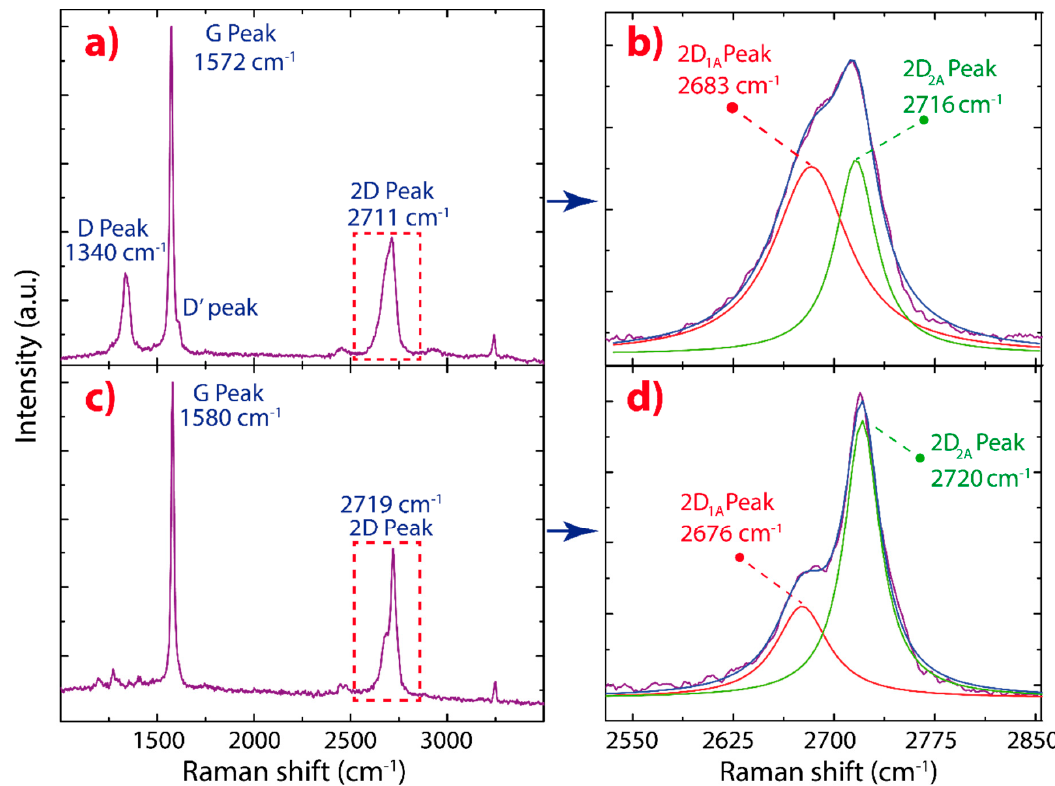
Figure 3. Raman spectra of ( a ) dispersed graphene after hydrothermal treatment and 3 h of sonication in 0.1 mg mL − 1 CTAB aqueous solution, fabricated by drop casting of dispersion, and ( c ) pristine graphite. ( b – d ) Fitting of the 2D peaks with two Lorentzian functions. The intensity was normalized by the G peak.